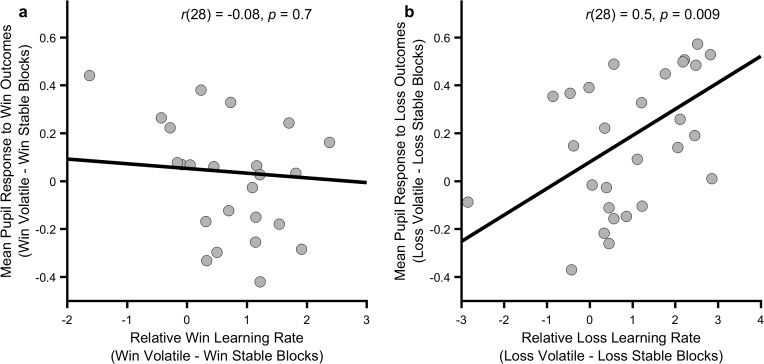
Relationship between behavioural and physiological measures.The more an individual altered their loss learning rate between blocks, the more that individual’s pupil dilation in response to loss outcomes differed between the blocks (panel b; p=0.009), however no such relationship was observed for the win outcomes (panel a; p=0.7). Note that learning rates are transformed onto the real line using an inverse logit transform before their difference is calculated and thus the difference score may be greater than ±1. Figure 4—figure supplements 1 and 2 describe the relationship between these measures and baseline symptoms of anxiety and depression.